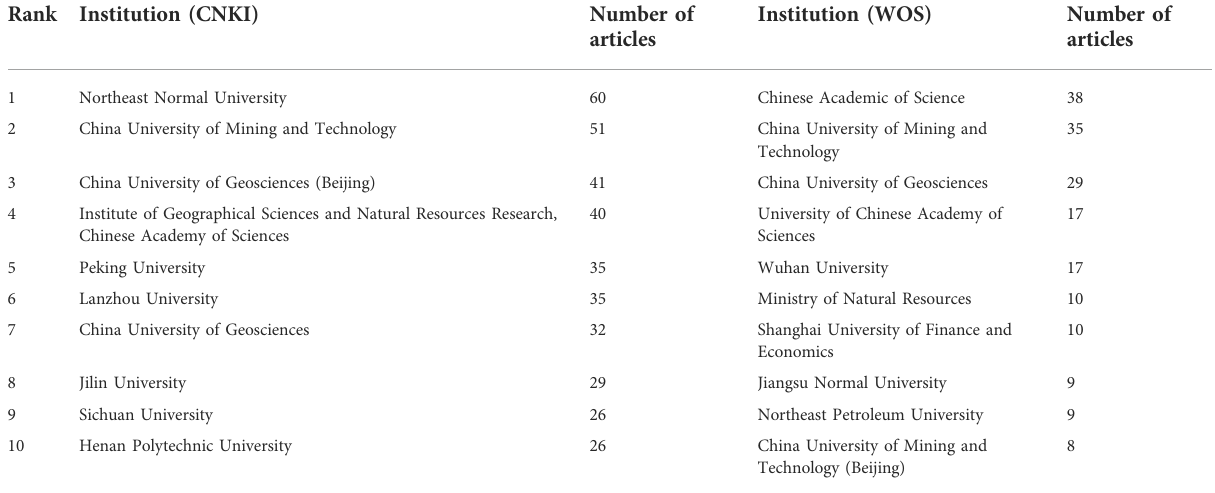
TABLE 2 Number of publications published by research institutions in resource-based cities (top 10).